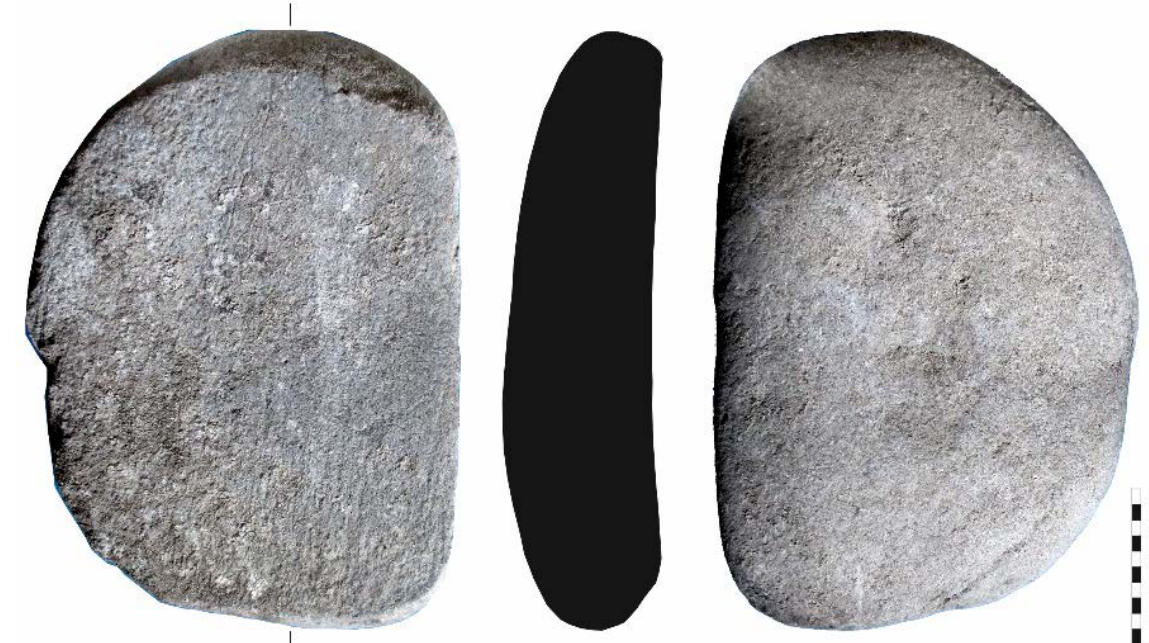
Figure 2. Grinding slab: workface, length section and base (scale in cm).